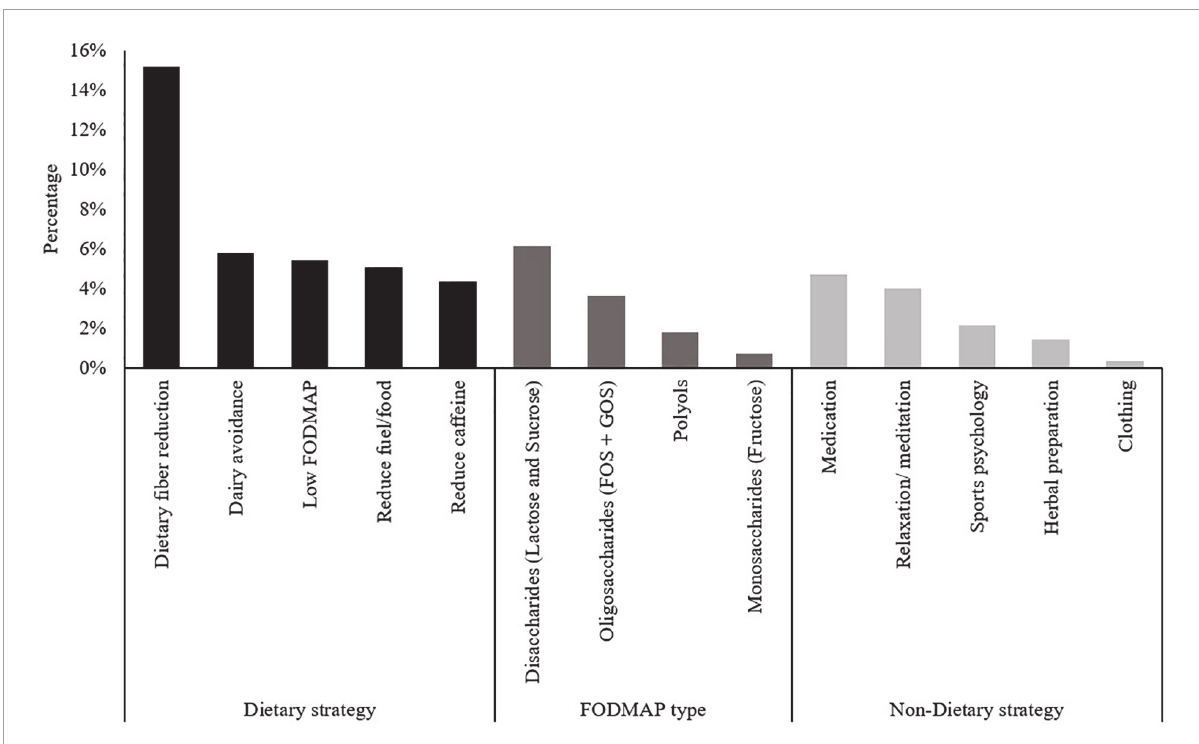
FIGURE2 Content review of endurance athletes’ five most common dietary strategies, including specific FODMAP groups described, and non-dietary strategies used to reduce exercise-associated gastrointestinal symptoms. FODMAP, fermentable oligosaccharide disaccharide monosaccharide and polyols; GOS, galacto-oligosaccharides; FOS,